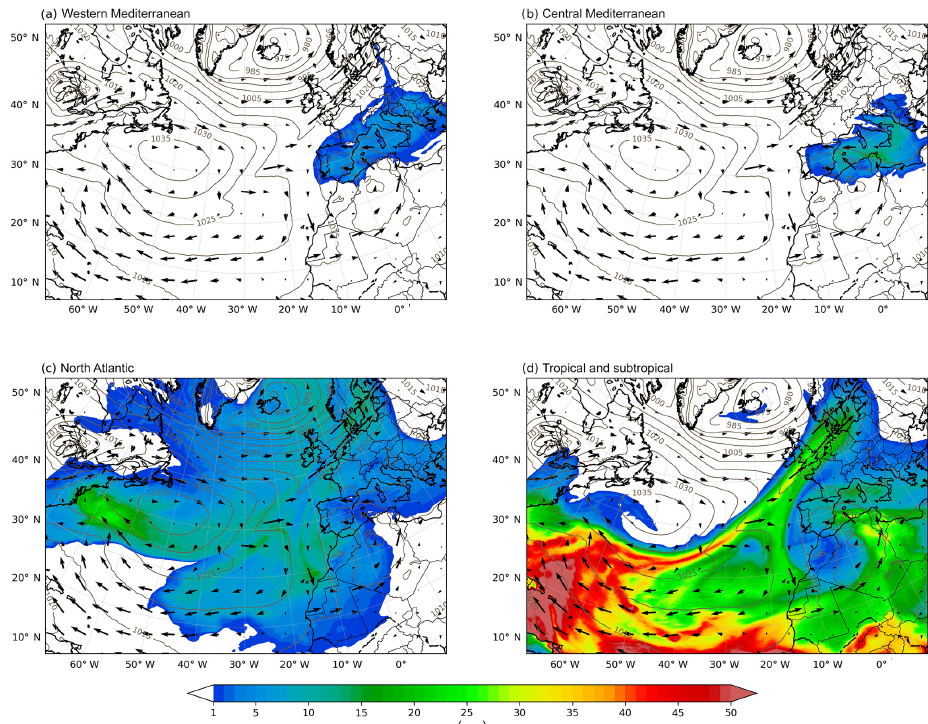
Figure 5. Total precipitable water (in millimetres) coming from the western Mediterranean (a) , the central Mediterranean (b) , the North Atlantic (c) and from the tropical and subtropical Atlantic along with tropical Africa, on 20 October at 12:00UTC. Contours show mean sea level pressure (in hPa) and arrows show the vertically integrated moisture flux (in kgm − 1 s − 1 ).